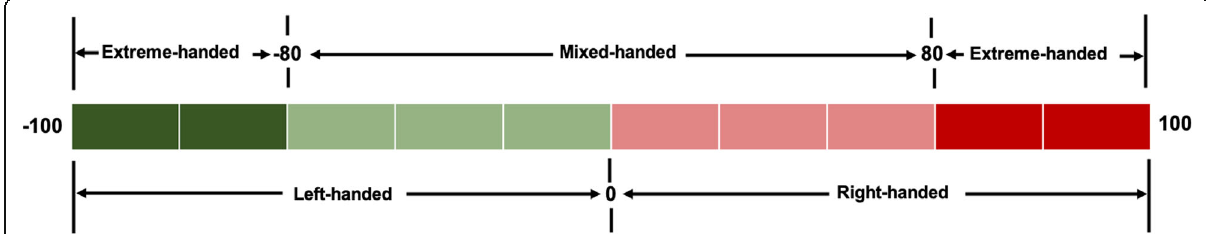
Fig. 4 Handedness categorization measured by the Edinburgh Handedness Inventory. For handedness direction, if the laterality quotient (LQ) score was within the range of − 1 to − 100, then the subject was considered left-handed. If the LQ score was within the range of + 1 to + 100, then subject was considered right-handed. For handedness strength, if the LQ score was between − 80 and + 80, then the handedness strength was mixed. If the LQ score fell in ranges of either − 100 to − 80 or + 80 to + 100, then the handedness strength was assigned as extreme